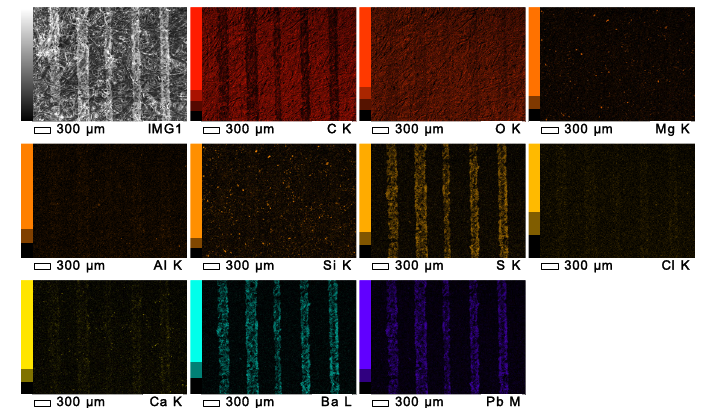
Figure 7. SEM-EDS mapping image of area 5-a.